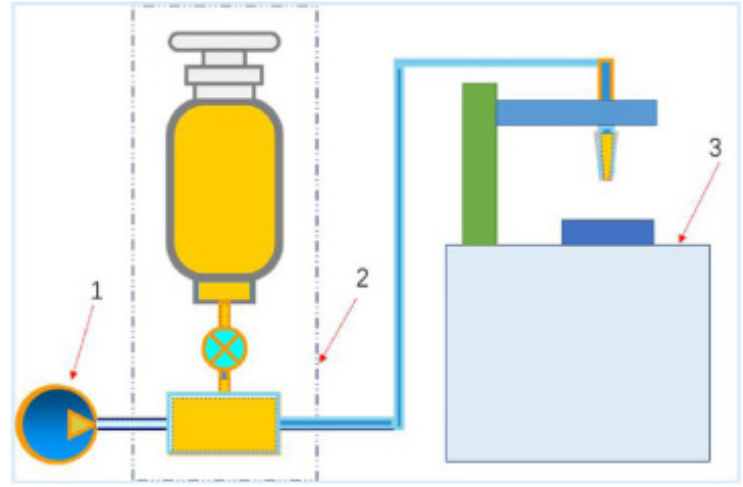
Figure 5. Schematic diagram of the working principle: 1—high-pressure pump, 2—premixed AWJ, 3—3D computer numerical control platform (Reprinted with permission from Ref. [73]. 2020, copyright Elsevier B.V.).